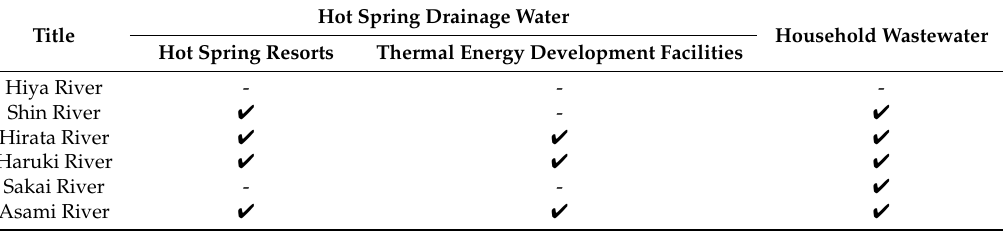
Table 1. Drainage water from different sources in